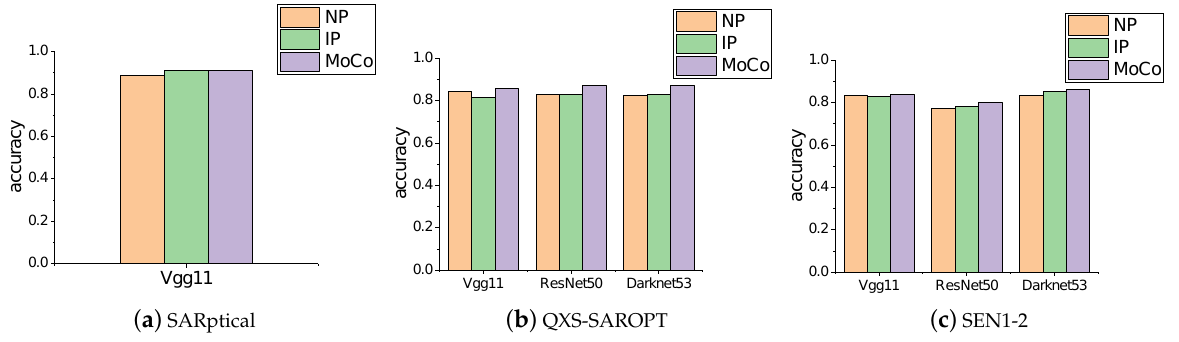
Figure 5. Visualization of the accuracy results of BNN with NP, IP, and MoCo pre-training on three datasets.